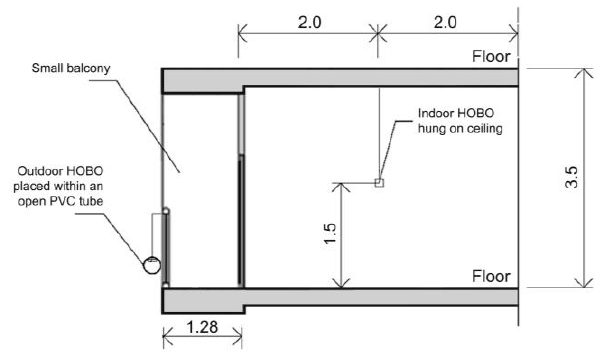
Fig. 9. Section of the C apartment